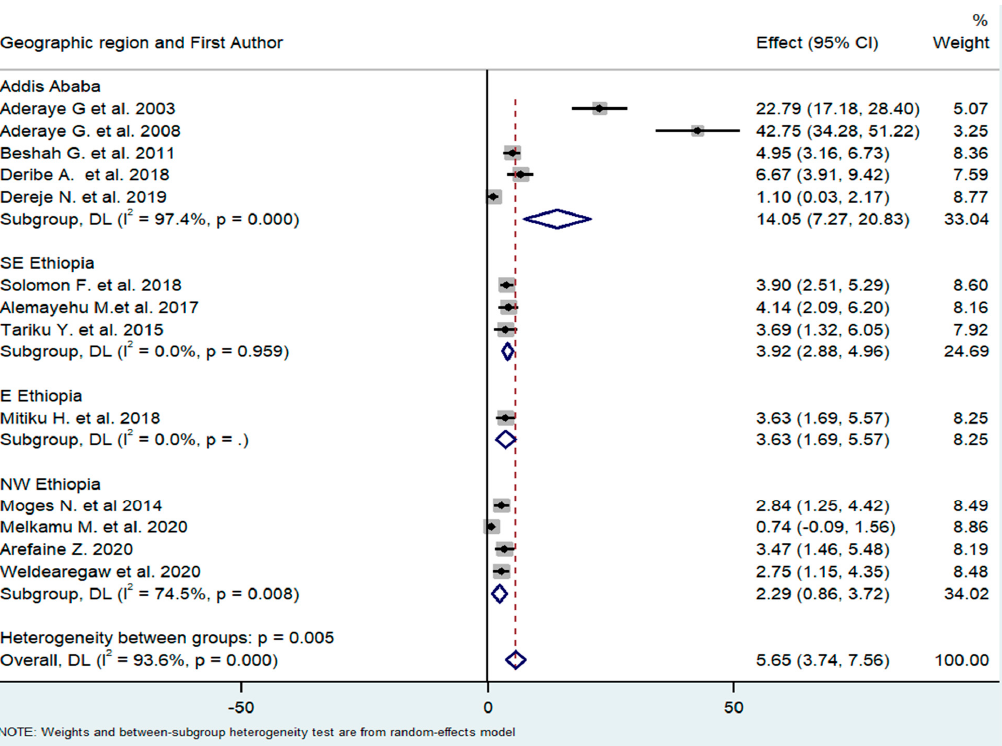
Figure 5. Subgroup analysis by geographical regions where the study was carried out [18,21,26–